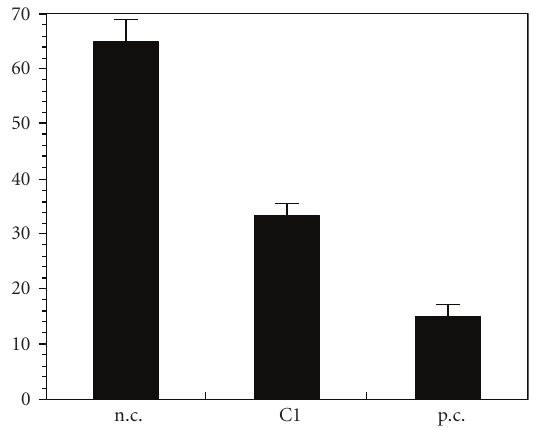
Figure 6: Prothrombin time assay . PT assay was performed for determination of coagulant activity of dialyzed rFVII. Coagulation time measured for dialyzed rFVII produced from transfected I.L.L. (C1: clone 1), commercially available rFVIIa as a positive control (p.c.), purified sample obtained from untransfected I.L.L. as a negative control (n.c.). A reduction in clotting time of about (33 ± 3) seconds with the purified rFVII was observed. Data are shown as mean ± SD.